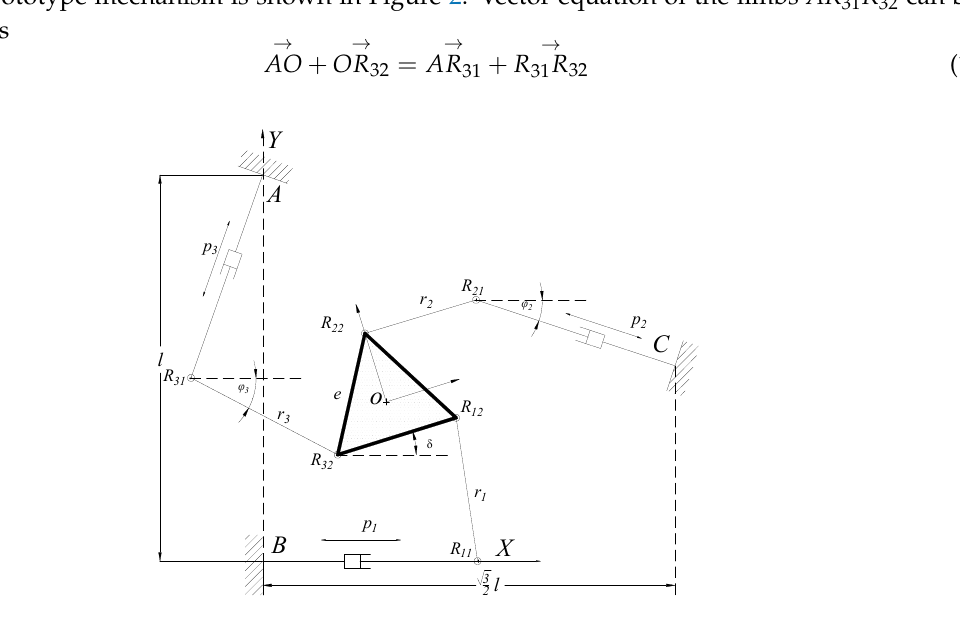
Figure 2. 3-PRR planar parallel prototype mechanism.